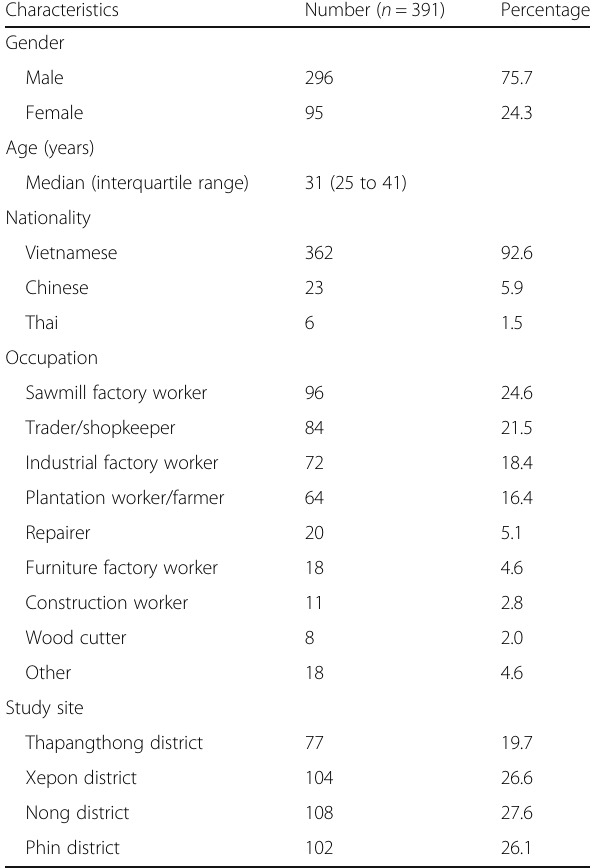
Table 1 General characteristics of study participants Characteristics